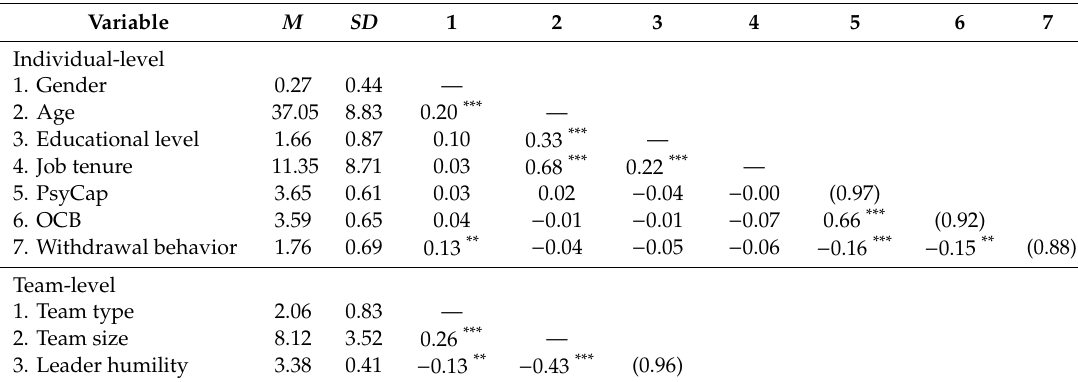
Table 2. Mean, standard deviation, and correlation coe ffi